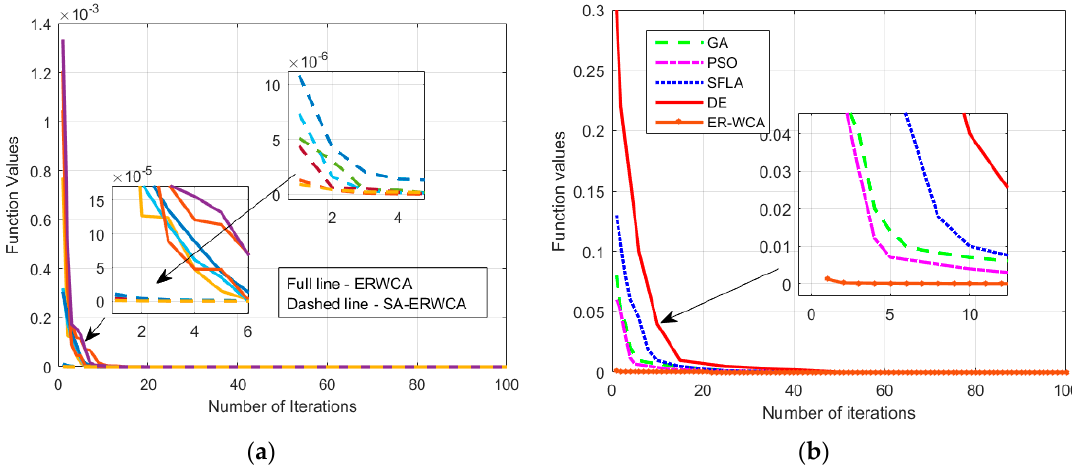
Figure 5. Convergence curves: ( a ) SA-ERWCA and ERWCA; and ( b ) other